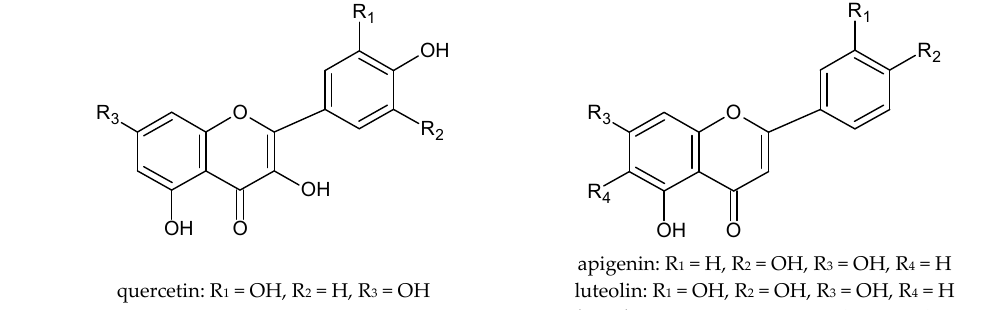
Figure 1. The chemical structure of selected flavonoids.